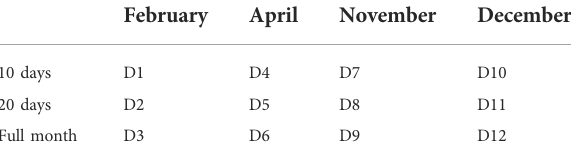
TABLE 2 Datasets for model identi fi